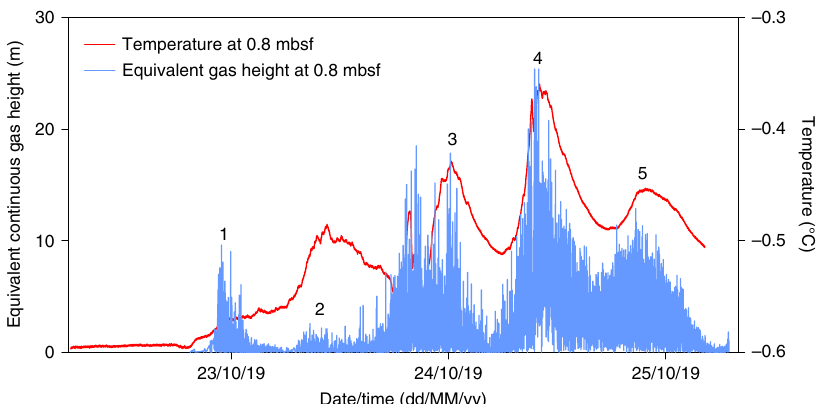
Fig. 5 Gas plume heights. Equivalent continuous gas plume heights versus time (blue curve) derived from pore pressure measured at 0.8 mbsf. The plume height peaks (indicated by numbers in the fi gure) coincides with temperature peaks measured at the same level (red